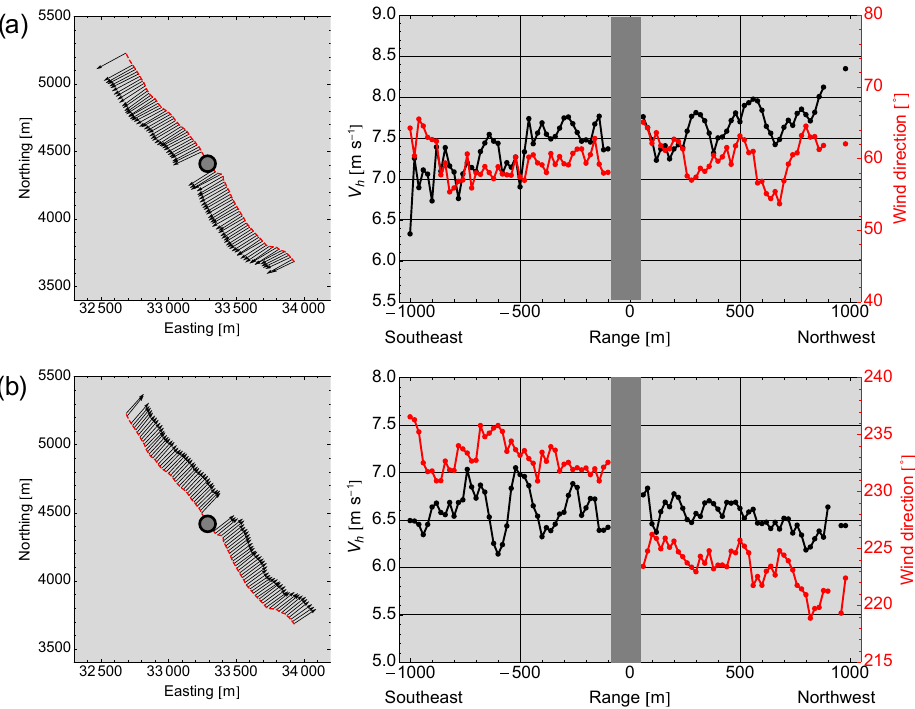
Figure 11. Wind vectors, wind speed and direction (10min averaged) 80ma.g.l. along the south ridge for wind dominant directions acquired using the ridge scan performed by the long-range WindScanner system: (a) northeast (measurements taken on 7 June 2015 from 03:30 to 03:40UTC); (b) southwest (measurements taken on 21 June 2015 from 21:42 to 21:52UTC). Black line, horizontal wind speed; red line, wind direction; dashed red line, ridge scan; grey circle (left) and rectangle (right) are areas where measurements are erroneous due to the presence of the wind